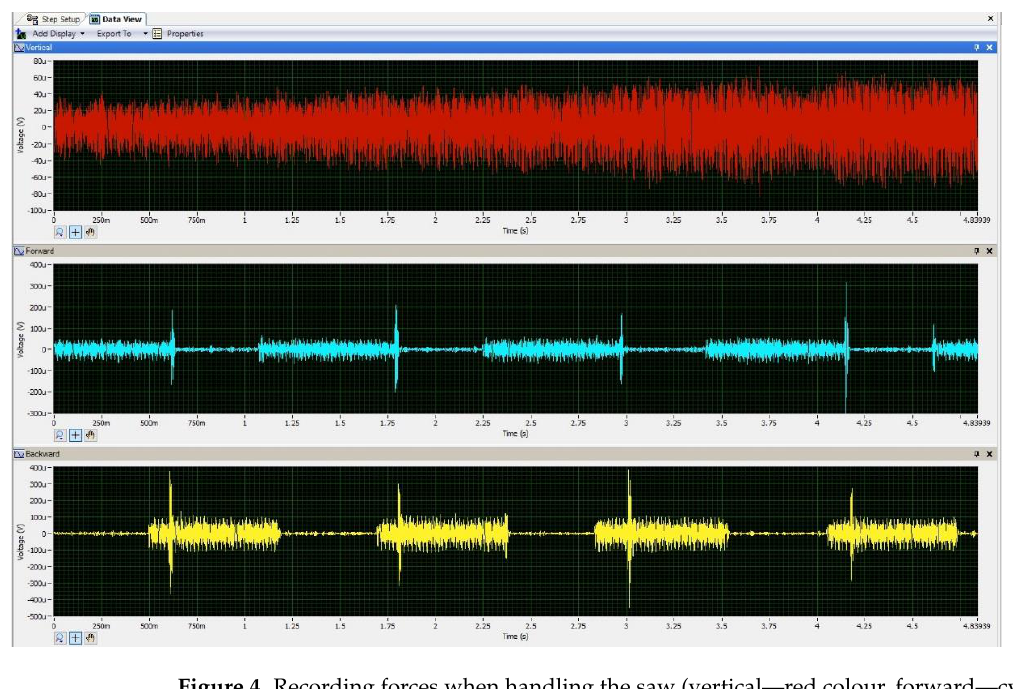
Figure 3. Equipment for determining push-pull (shear) and vertical (z axis) forces. Five-second-long signals were captured with a frequency of 2 kHz. Approximately equal values were found for the movements in the longitudinal direction for pushing and pulling the saw (forwards and backwards), and for the vertical direction an approximately constant force was observed.